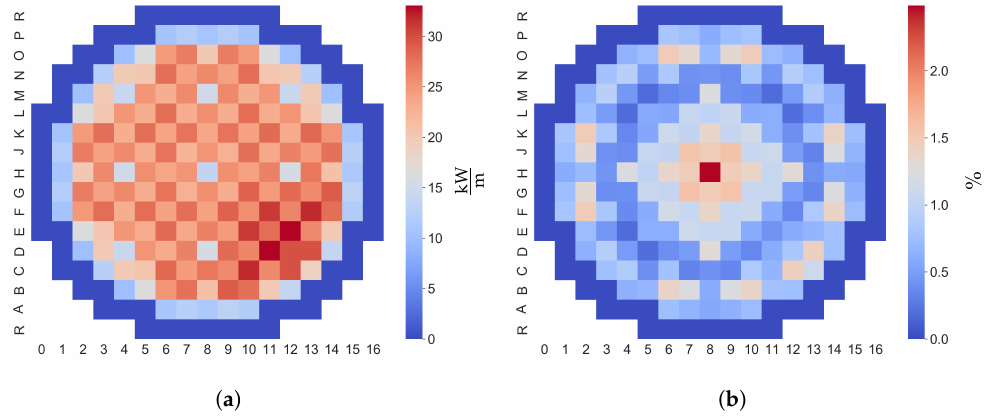
Figure 35. Radial profile of P ave